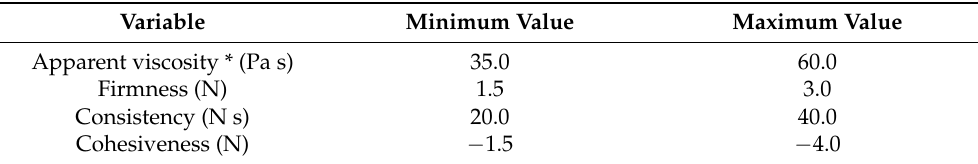
Table 1. Minimum and maximum target rheological values of plant-based pur é es for OD patients’ diets. Variable Minimum Value Maximum Value Apparent viscosity * (Pa s) 35.0 60.0 Firmness (N) 1.5 3.0 Consistency (N s)